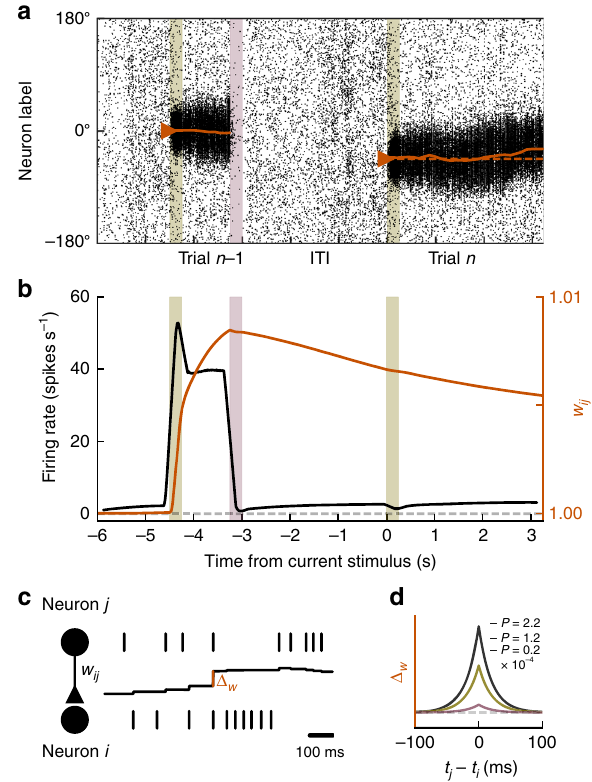
Fig. 2 Ring attractor network with synaptic STP shows serial dependence. Simulations of two consecutive working memory trials (current trial n , previous trial n − 1) in a spiking neural network model with bump-attractor dynamics ( “ Methods ” ). a Spike times ( x -axis) of excitatory neurons, ordered on y -axis by preferred angular location. Colored bars in a , b mark previous and current stimulus onset times (olive) and previous response (red). The solid orange line shows the population vector decoded from fi ring rates (sliding windows of 250 ms). In trial n , the active memory representation got biased towards the memory representation in trial n − 1. b Firing rate (black) and potentiated weight trace w ij for neurons at 0° (orange) averaged over 1,000 trials and 20 neurons centered around 0°. Spiking activity and synaptic strength increased during trial n − 1 delay and decreased after the response. At current stimulus onset, information about trial n − 1 remained only in the potentiated weight trace. To facilitate interpretation, we excluded trials for which any neuron participated in previous and current-trial delay activity (i.e., showed fi ring rates >10 spikes s − 1 after stimulus onset in trial n ). c , d Associativity and decay of modeled STP. The strength of each individual synapse is determined by w ij ( c , middle black trace), which is potentiated at each spike by an amount Δ w that depends on the relative spike times t j and t i of pre- and postsynaptic neurons, respectively, and on the potentiation factor P that is chosen to represent different strengths of STP (different colored lines in ( d ); “ Methods ” , Eqs. (15) and (16)), and it is reduced by an amount relative to the synaptic strength at each presynaptic spike, resulting in activity- dependent decay (Eq.